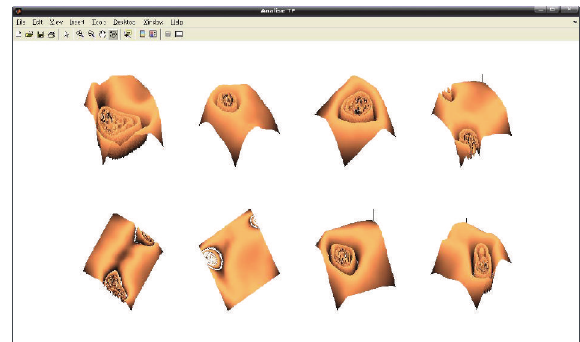
Figure 9: GenTP analyse user’s interface.